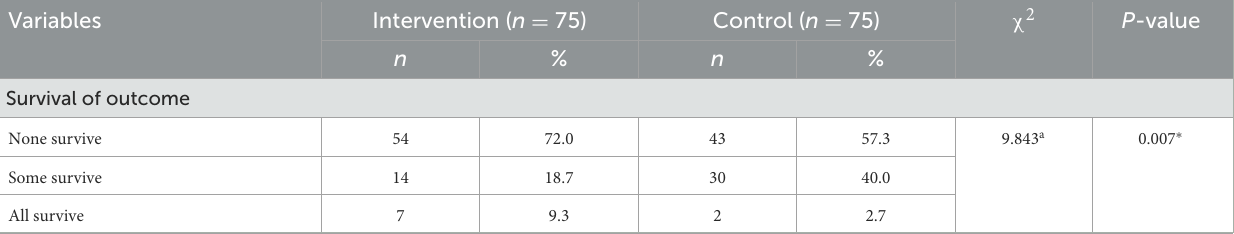
TABLE 2 Effectiveness of video self-instruction (intervention group) and instructor-led (control group) on CPR knowledge level across time points (pretest, posttest, 1 month, 3 month, and 6 month), adjusted with covariates.